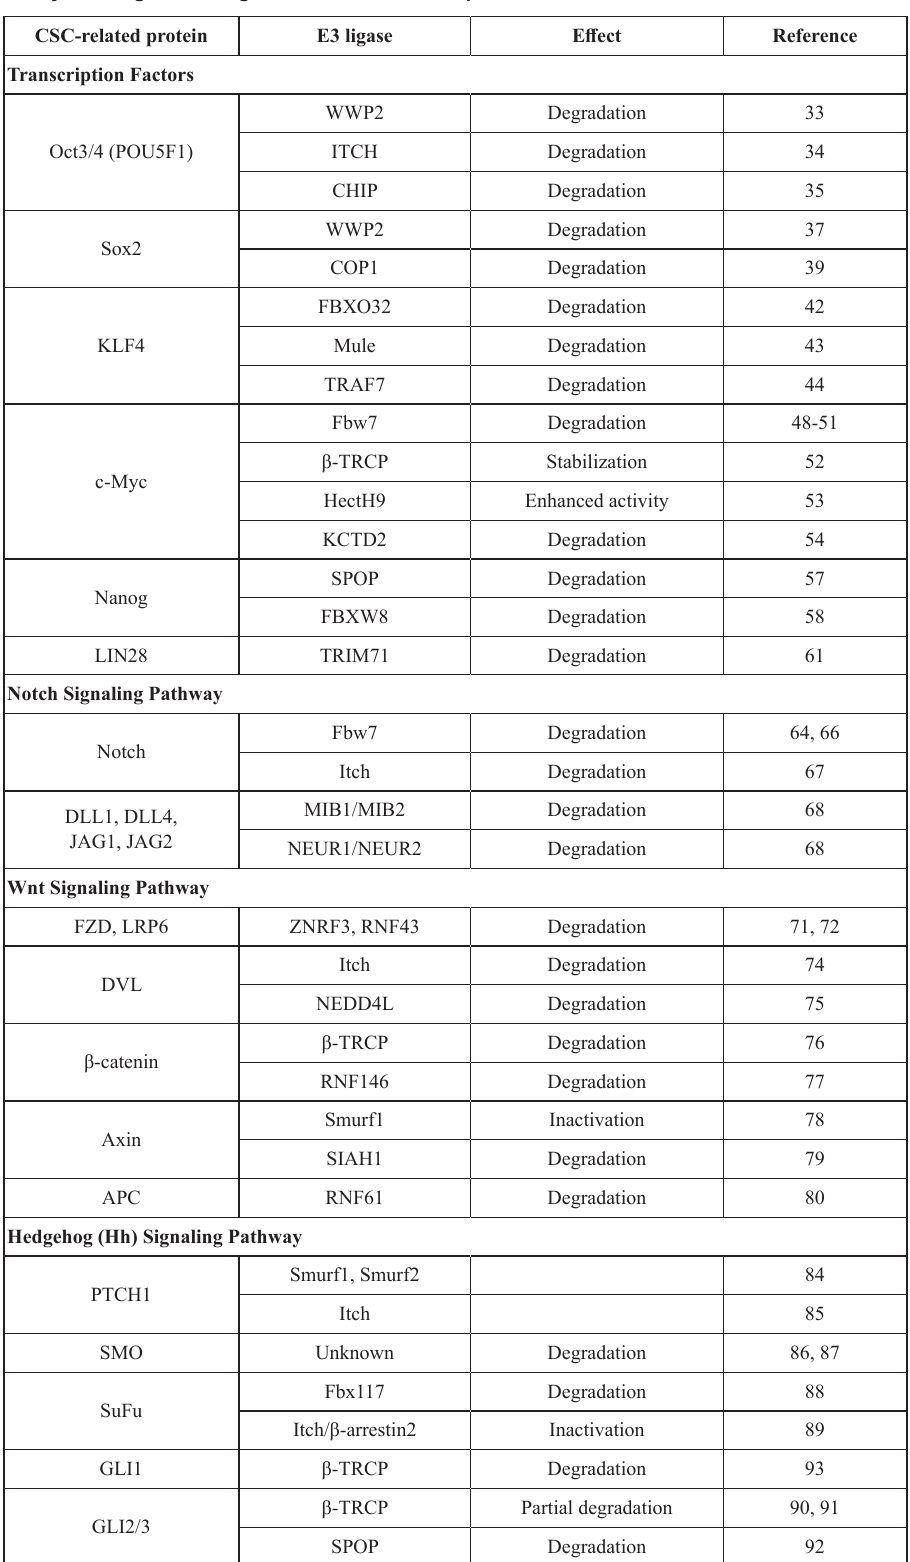
Table 1: The summary of E3 ligases in regulation of CSC-related